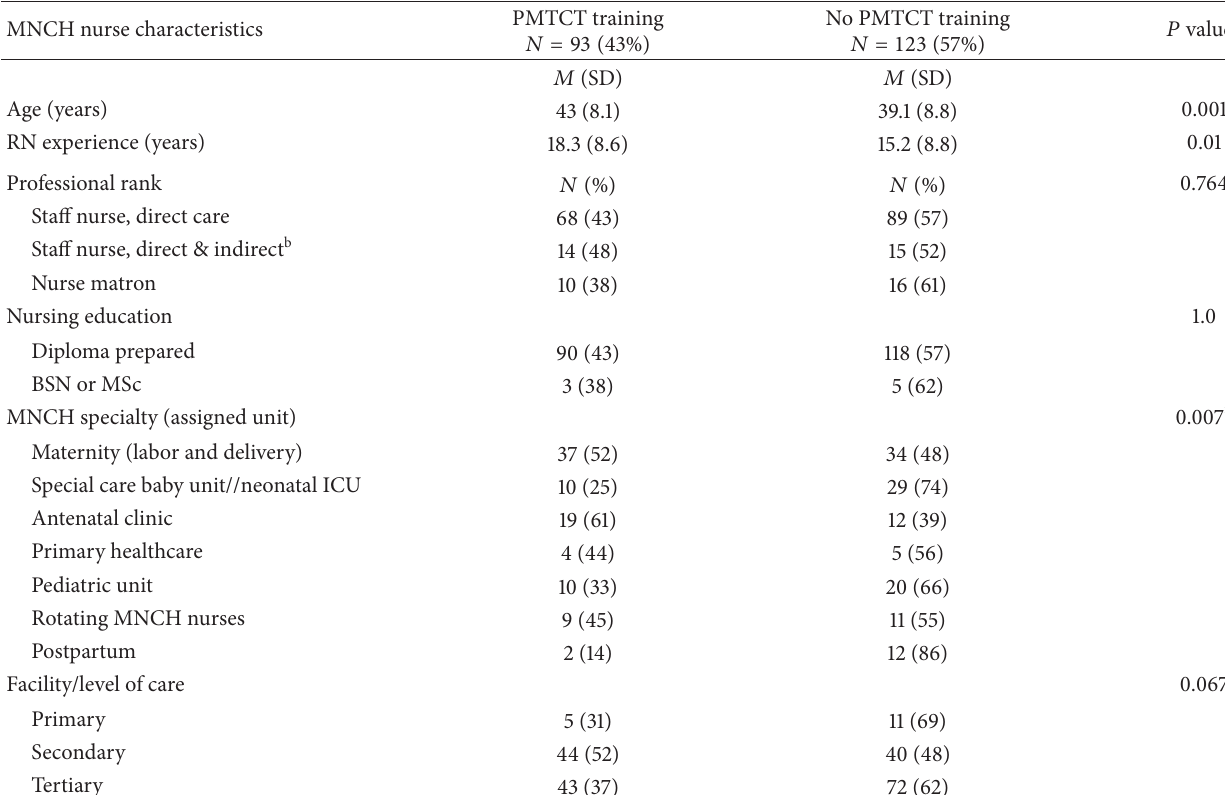
Table 3: Nurse demographic characteristics by PMTCT training, 𝑁 = 223 a . MNCH nurse